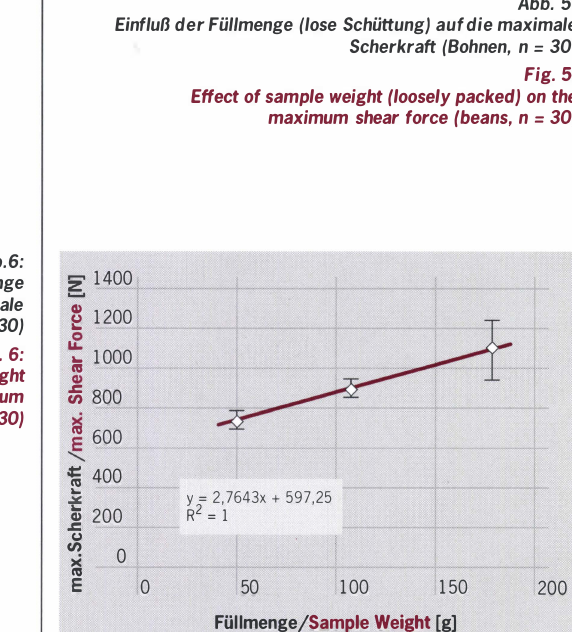
Effect of sample weight (loosely packed) on